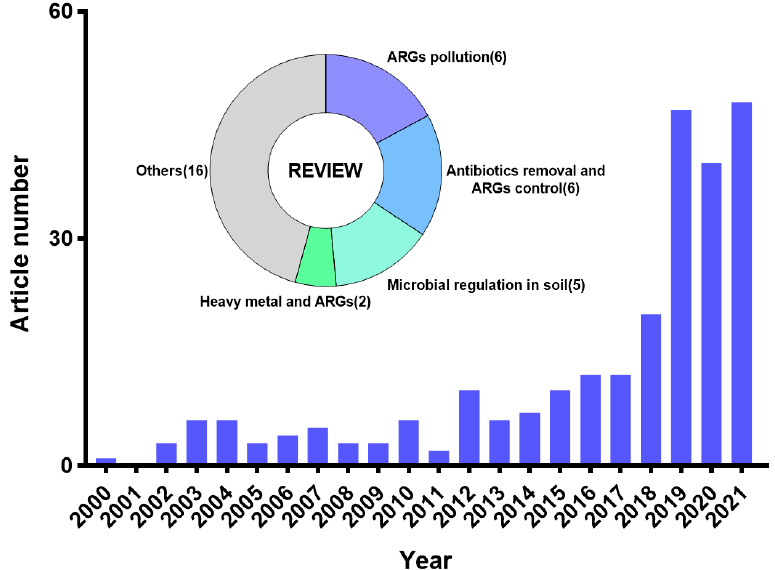
Figure 2. Search results and thematic analysis of the reviews.